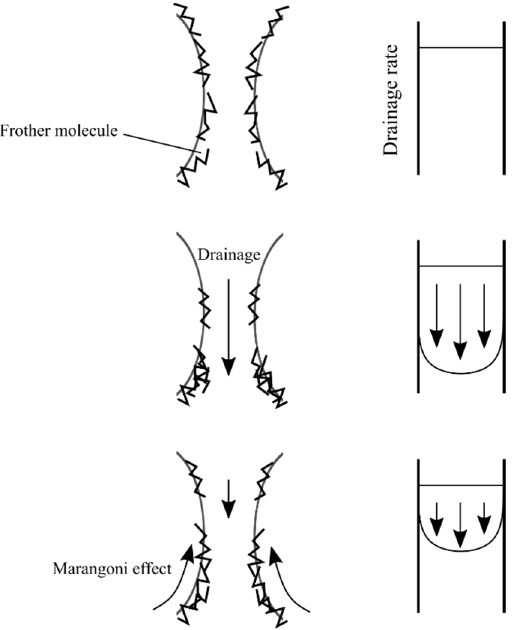
Figure 8. Visualization of the Marangoni effect to resist drainage. Adapted from Tan, et al. [26].